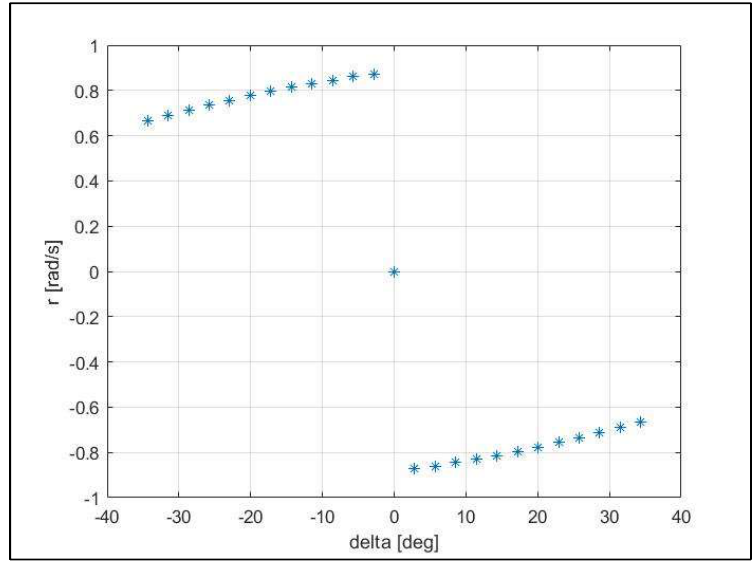
Figure 4. Equilibrium yaw rates as a function of roadwheel angle.